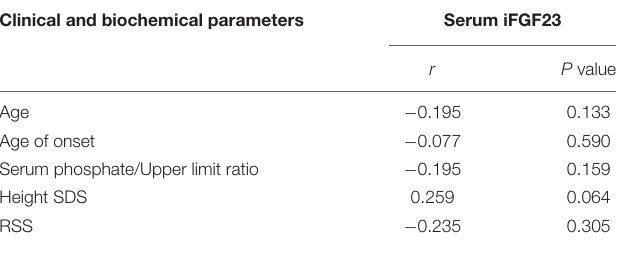
TABLE 4 | Correlation analyses of circulating iFGF23 and other clinical and biochemical parameters. Clinical and biochemical